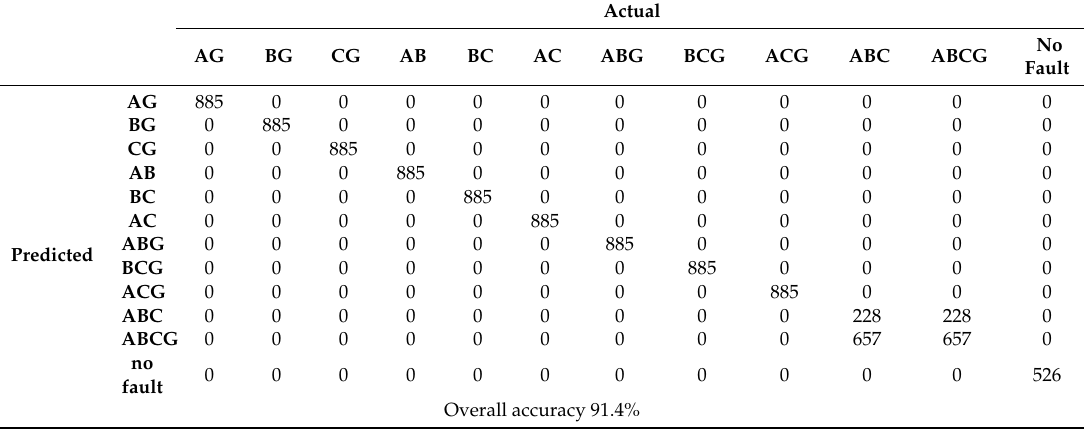
Table 5. Detection and classification confusion matrix for scenario